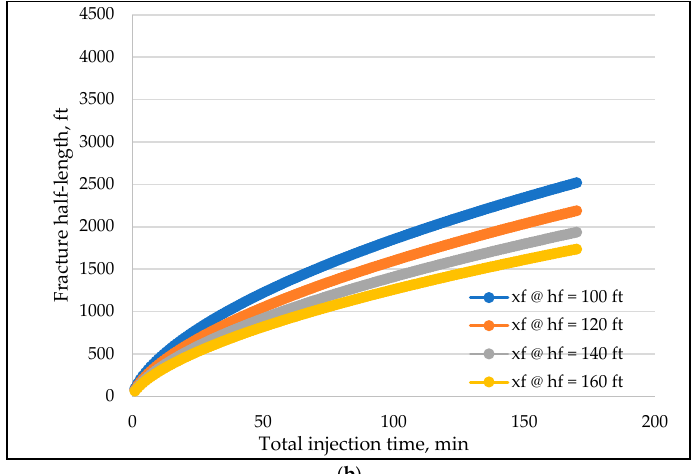
Figure 9. ( a ) Impact of fracture height variation on fracture half-length versus total injection time for the PKN-C model; ( b ) impact of fracture height variation on fracture half-length versus total injection time for the PKN-C-DP model. Figure 10a,b present the impact of changing the fracture half-length on the fracture height growth; a higher fracture height growth is achieved in the single porosity P3D-C model in Figure 10a, whereas the fracture height growth is more confined in the dual- porosity system due to the fugitive fluid leak-off that limits the fracture height growth and results in a more confined fracture height in Figure 10b.